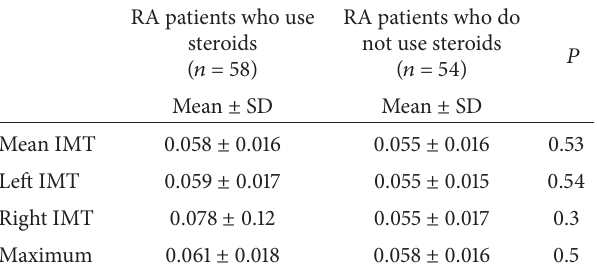
Table 14: Comparison of ultrasonographic duplex findings in RA patients who use steroids and RA patients who do not use steroids.